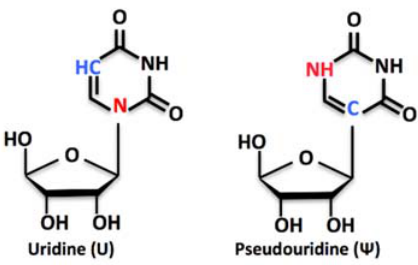
Figure 1. Structure formulae of uridine and pseudouridine.